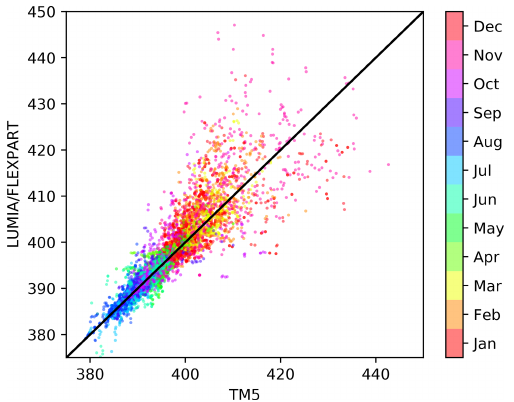
Figure 4. LUMIA CO 2 concentrations obtained from TM5– FLEXPART vs. from TM5 with the CO 2 fluxes used as the prior of the TM5 inversion (background). The color of the dots shows the observation